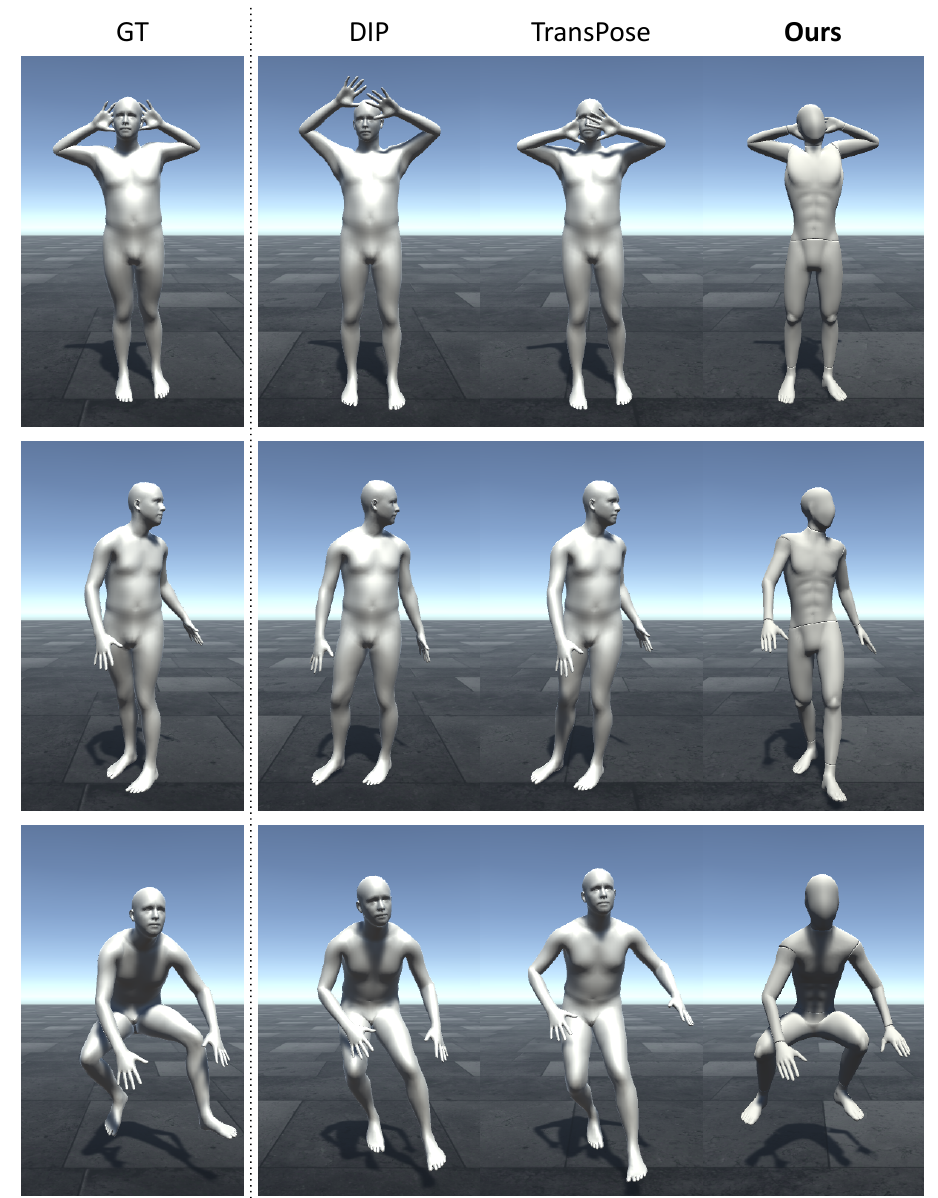
Figure 11. A qualitative comparison between the online pose estimation results of our method and those of previous works: the first column shows the ground-truth of the selected frame from the TotalCapture dataset, then the reconstructed SMPL poses from the estimation results of DIP are in the second column and those of TransPose are in the third